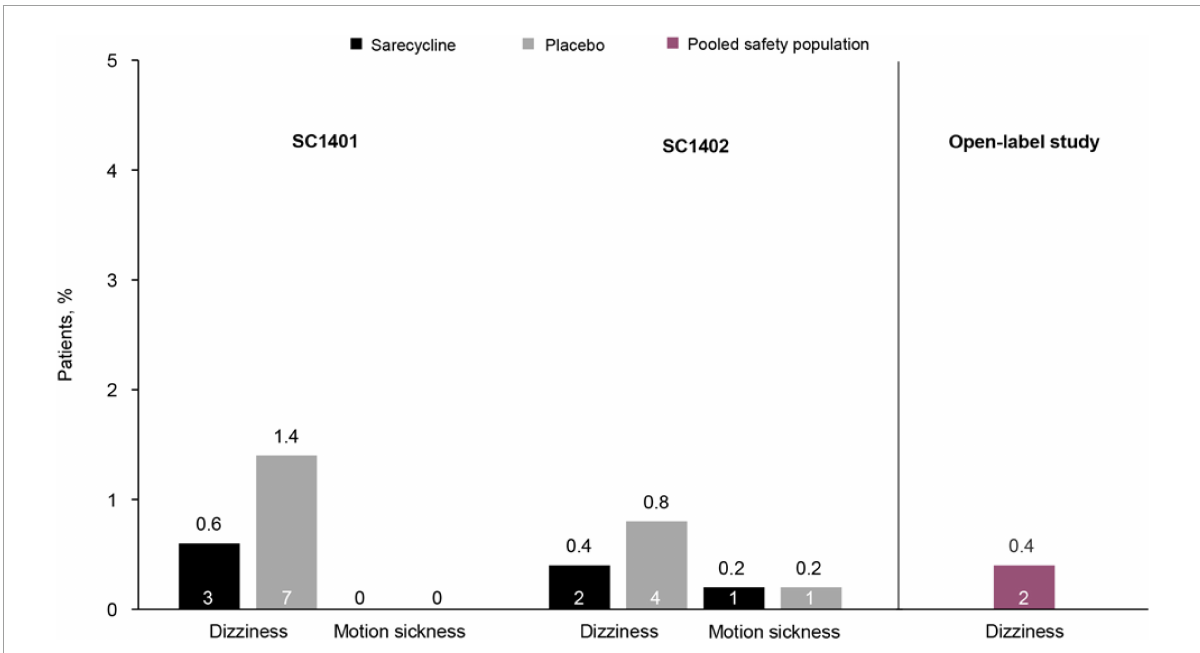
FIGURE1 Rates of vestibular-related adverse events in two phase 3 placebo-controlled clinical trials of sarecycline [SC1401 ( N = 964) and SC1402 ( N = 1026); representing the safety population] and a phase 3 open-label extension study ( N = 483) (8, 9). In the open-label study, rates of adverse events were pooled for patients who received placebo in the phase 3 clinical trials and then received sarecycline ( n = 236) and those who received sarecycline in the phase 3 clinical trials and continued receiving sarecycline in the open-label study ( n = 247). Motion sickness was not reported in the open-label study. The number of patients who experienced these adverse events is shown in each